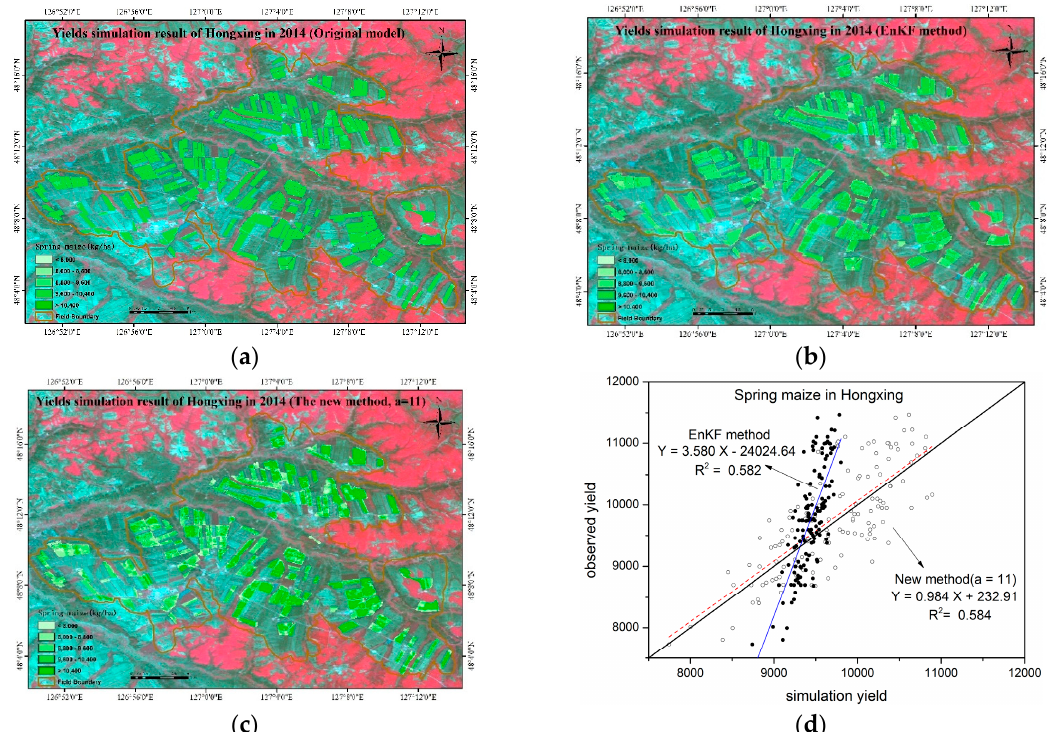
Figure 8. Yield simulation map and simulation accuracy of Hongxing in 2014: ( a ) simulation map of original model; ( b ) simulation map of EnKF; ( c ) simulation map of new method ( a = 11); ( d ) simulation accuracy result. Table 12. Spatial heterogeneity of yield simulation results between fields (kg/ha).